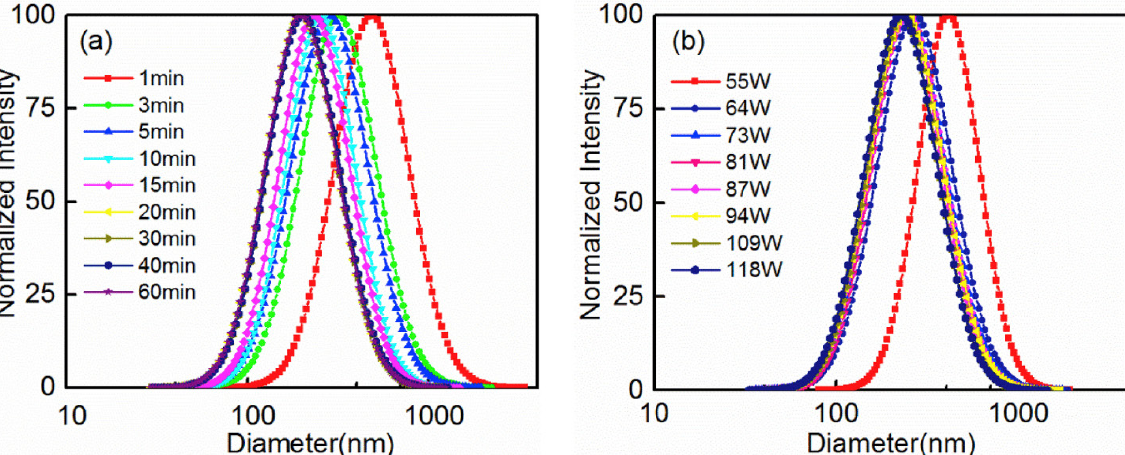
Figure 3: Particle size distributions of hybrid of GO/CNT particles in suspension at different (a) ultrasonication times and (b) ultrasonication power